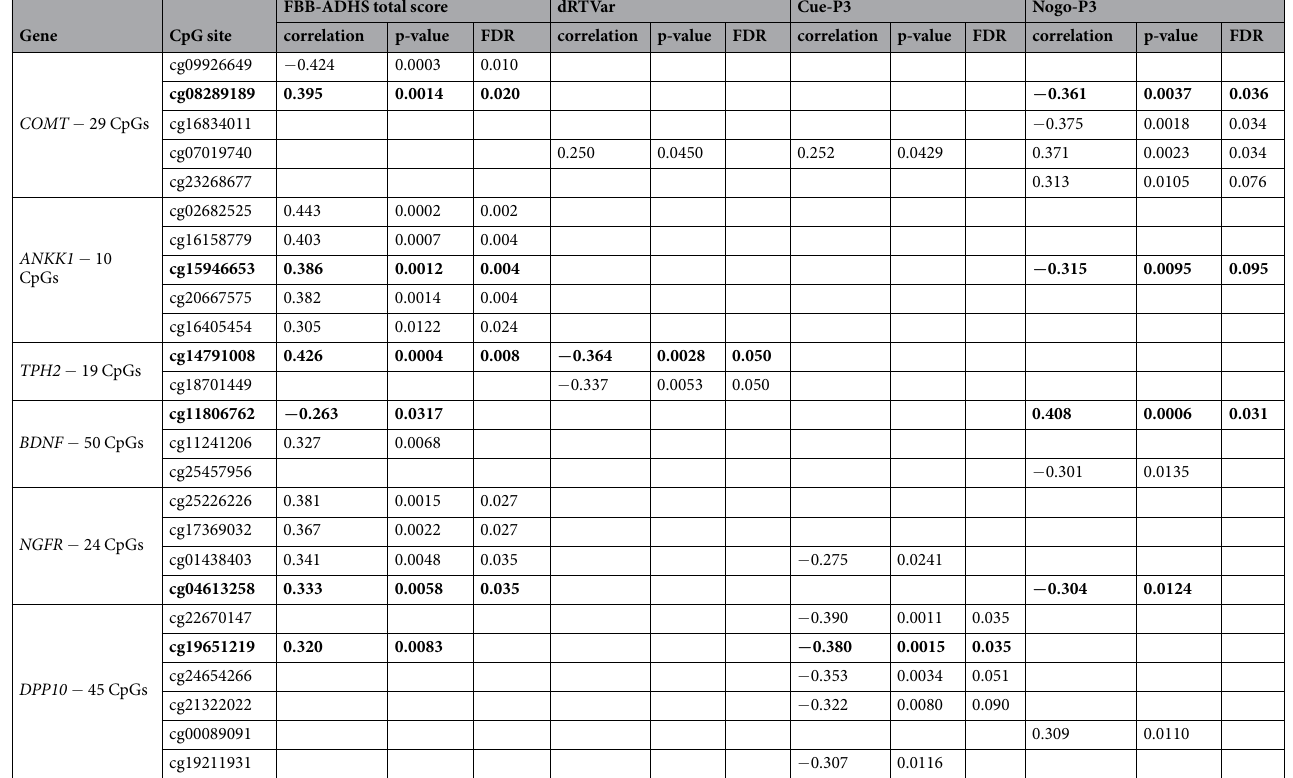
Table 2. Results of the DNA methylation analysis. Those genes fulfilling the combined statistical thresholds are presented. All probes linked to these genes with at least one correlation of medium effect are listed. Those CpGs fulfilling our statistical criteria (for details see text) are printed in bold. Only FDRs < 0.1 are listed. Abbreviations: FBB-ADHS (German ADHD rating scale); FDR = false discovery rate; dRTVar = difference of reaction time variability between blocks with and without motivational